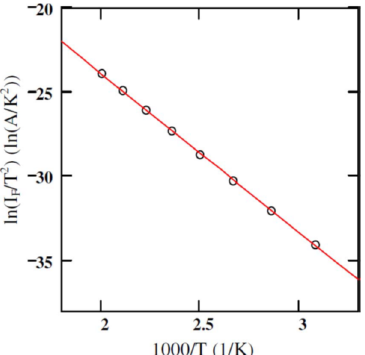
Figure 3. Activation energy plot for a 50 µm n-type 4H-SiC epitaxial layer (n-M50) SBD with 3.2 mm diameter Ni contact. The solid red line shows the linear fit to the experimental data.